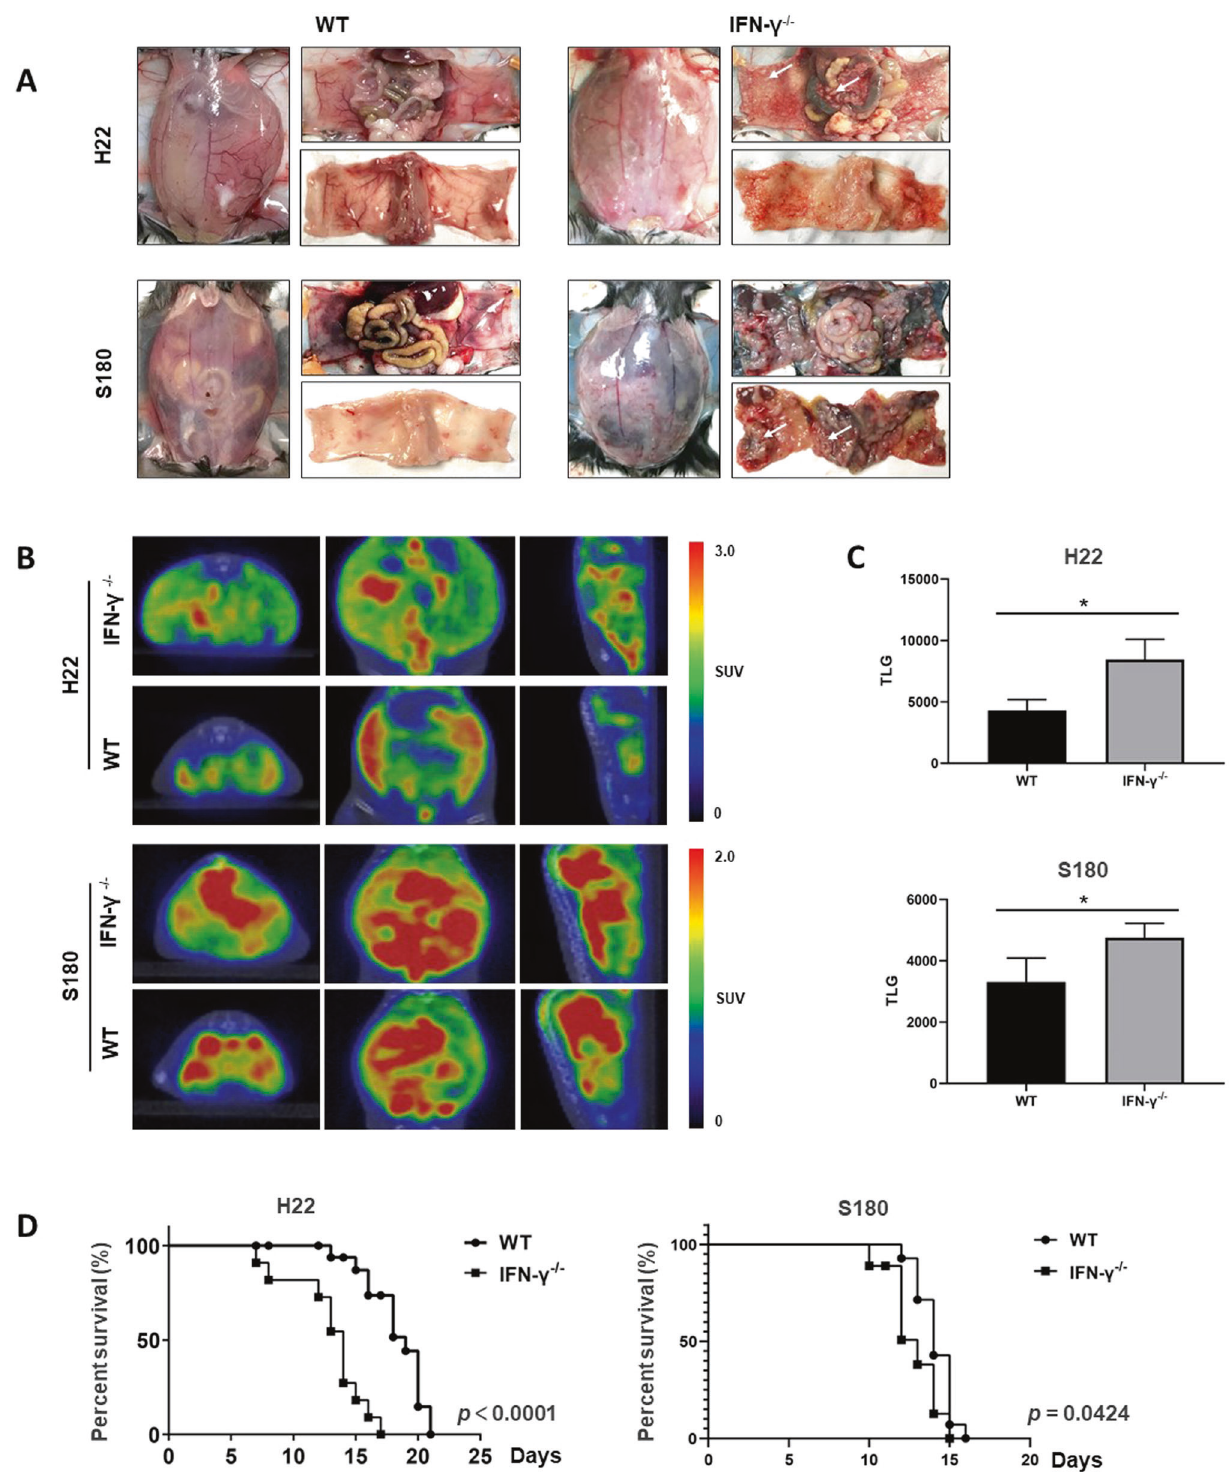
Fig. 4 Effects of IFN- γ on the growth of peritoneal carcinomatosis and the survival of mice. A Representative photograph of WT and IFN- γ − / − mice after intraperitoneal injection of H22 and S180 cells. Marked abdomen expansion and multiple tumor foci were observed at 14 days after the administration of tumor cells. Representative photography showed most of tumor cells were found in visceral peritoneum; B positron emission tomography and computed tomography imaging of WT and IFN- γ − / − mice with malignant ascites; C total lesion glycolysis (TLG) on PET/CT of WT and IFN- γ − / − mice with malignant ascites. The difference between two groups was determined by t test; D survival curve of WT and IFN- γ − / − mice with malignant ascites. The difference between two groups was determined by pairwise log-rank tests; * p ≤ 0.05, ** p ≤ 0.01, *** p ≤ 0.001, ns no signi fi cant.